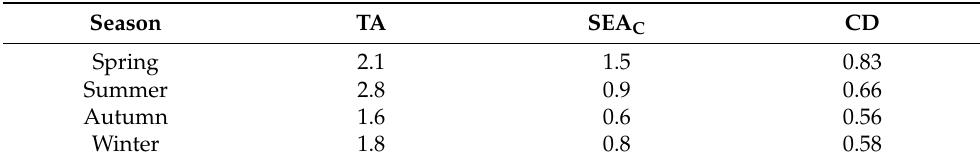
Table 2. Values of the Total Area of the convex hull (TA), the corrected Standard Ellipse Area (SEA C ), and the distance from the centroid (CD) calculated considering the factor “Season” on the isotopic contents of n = 68 specimens of Solea solea captured from January to December 2019 in the Central Adriatic Sea for a study of their diet. TA and SEA C are expressed as ‰ 2 .